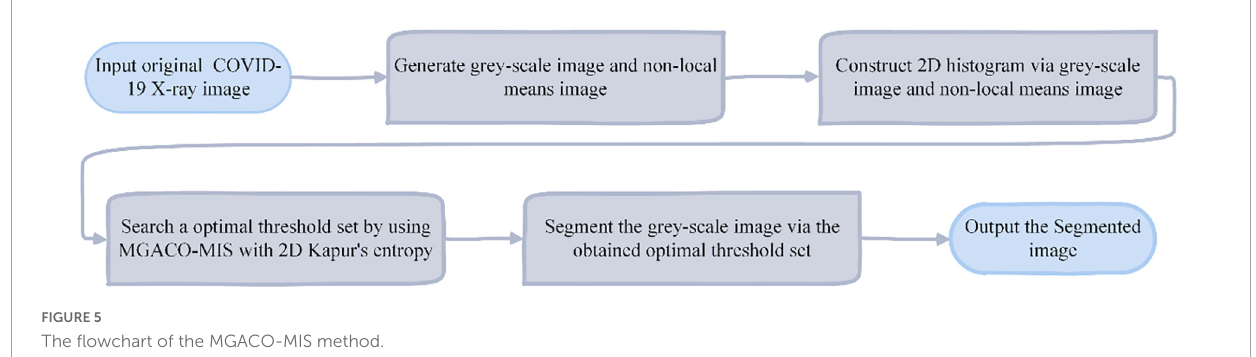
FIGURE5 The flowchart of the MGACO-MIS